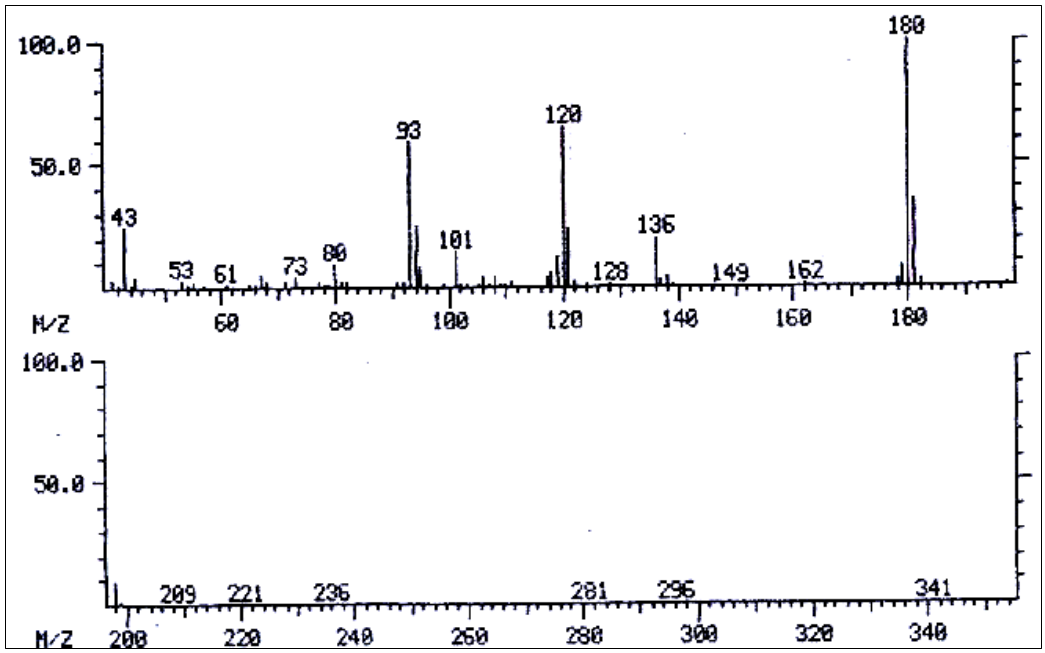
Figure 12. Mass spectrum of 7-acetyllycopsamine/7-acetyl intermedine/7-acetyl indicine/ 7-acetyl echinatine/7-acetyl rinderine.